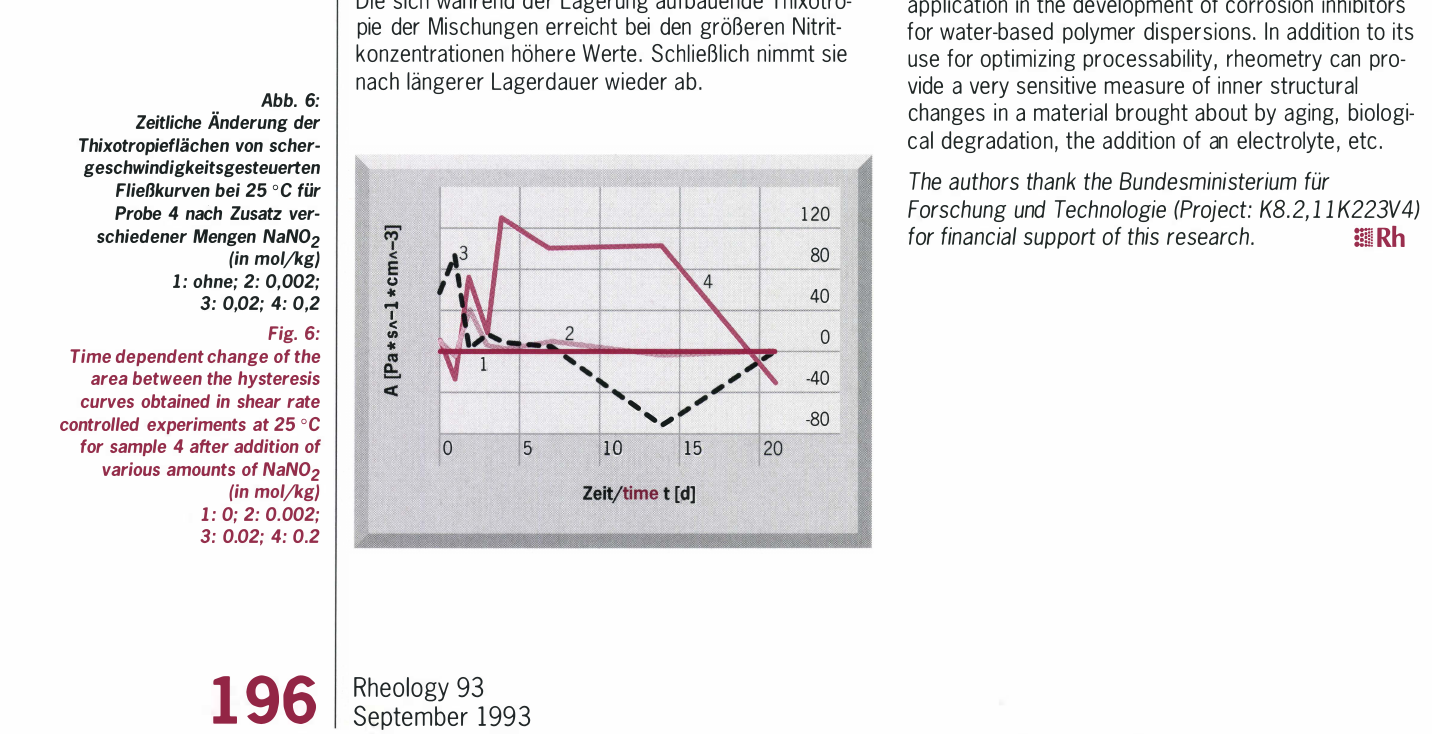
Fig. 6: Time dependent change of the area between the hysteresis curves obtained in shear rate controlled experiments at 25 o c for sample 4 after addition of various amounts of NaN02 (in moljkg) 1: 0; 2: 0.002; 3: 0.02; 4: